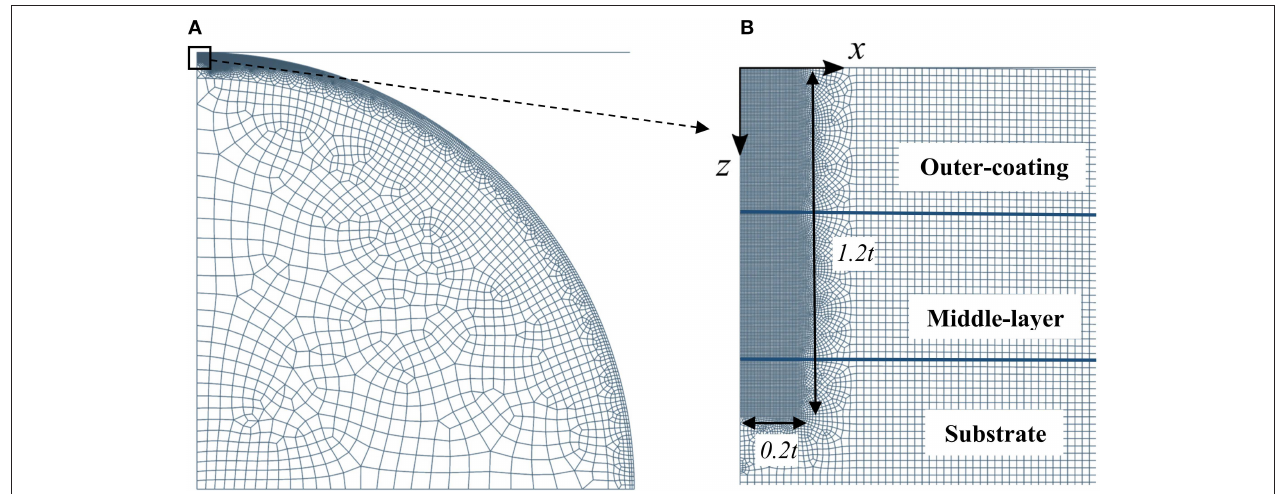
FIGURE 3 | Finite element model of the bilayer coated sphere pressed by a rigid flat (A) . Close-up of the mesh zone with highest element density (B) . ML/S and OC/ML interfaces are highlighted in (B) .